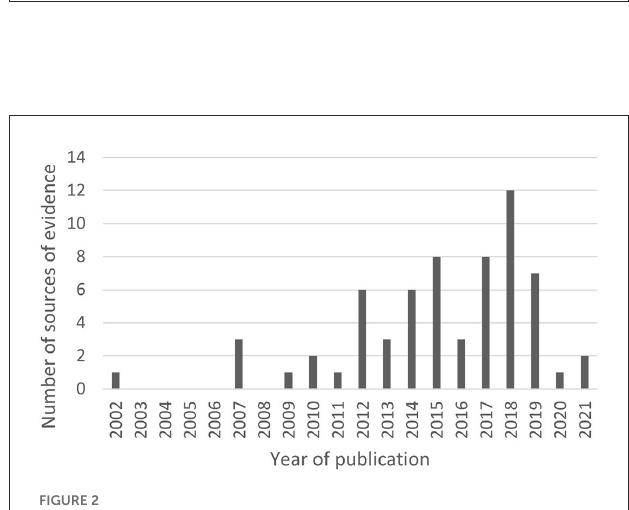
FIGURE2 Year of publication of included